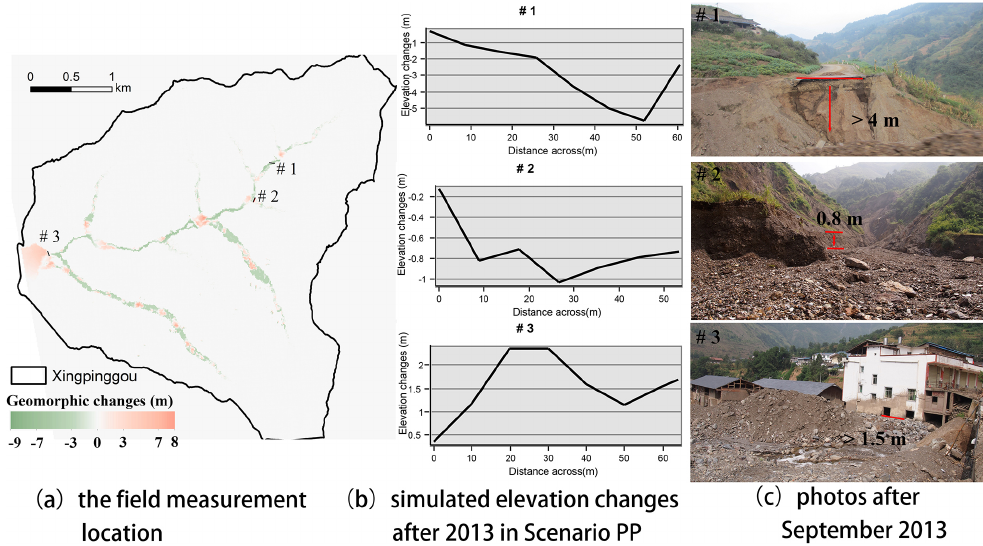
Figure 5. The comparison of cross-sections from the simulation results to the field measurements after 2013 in Scenario PP.